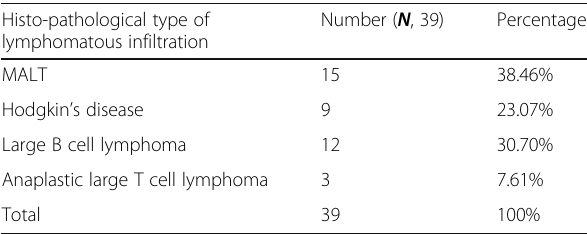
Table 2 Distribution of the patients according to the histo- pathological types of extranodal lymphoma Histo-pathological type of lymphomatous